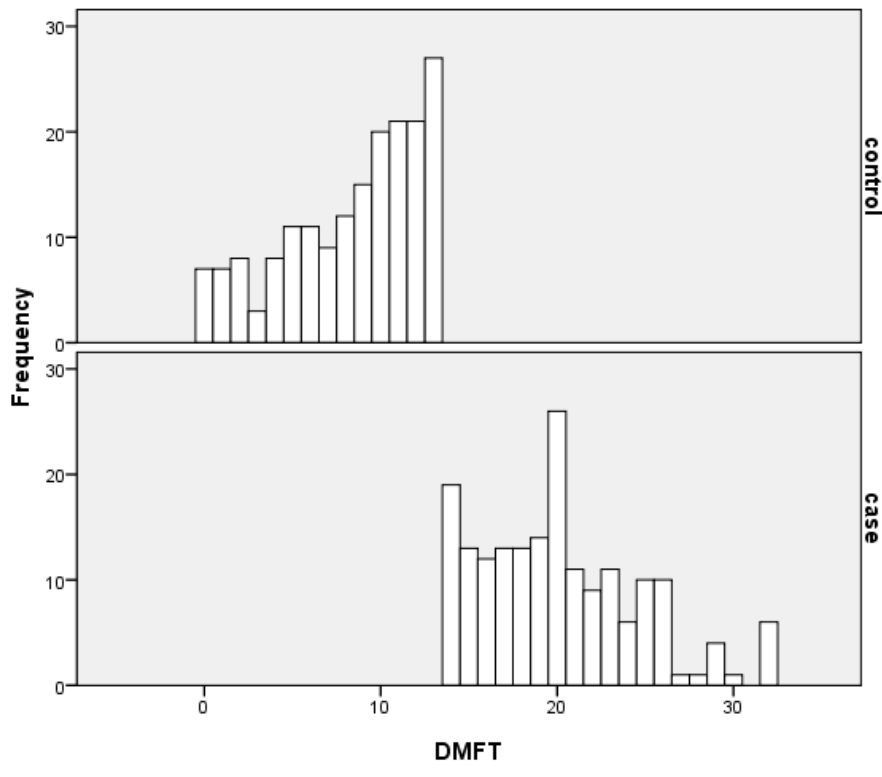
Figure 1. Distribution of DMFT in the case and control